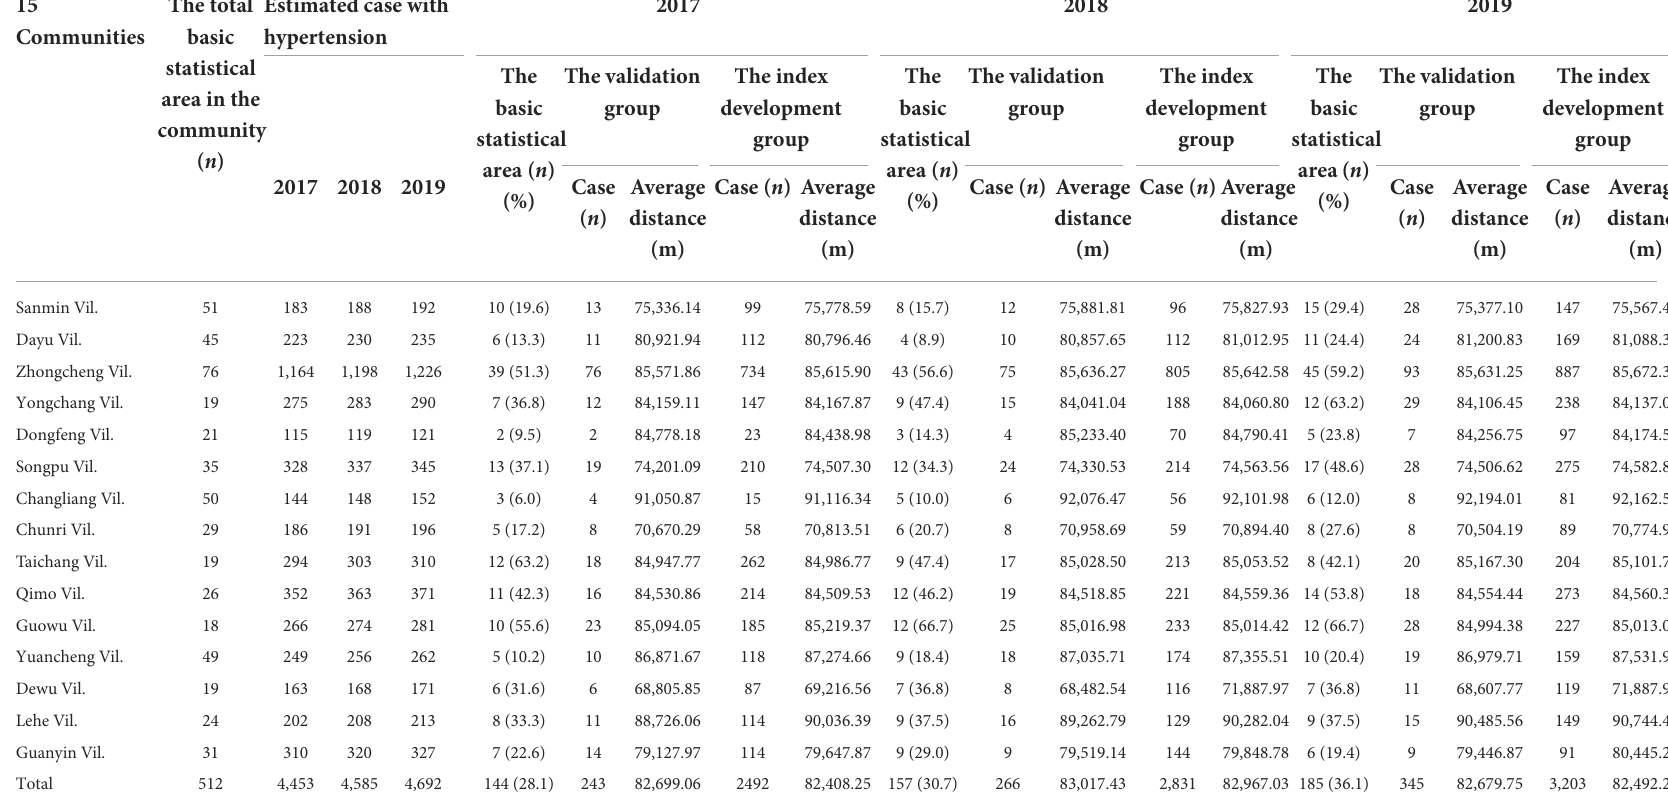
TABLE 5 The actual and estimated distances between living in 15 communities of Yuli and medical center among patients with